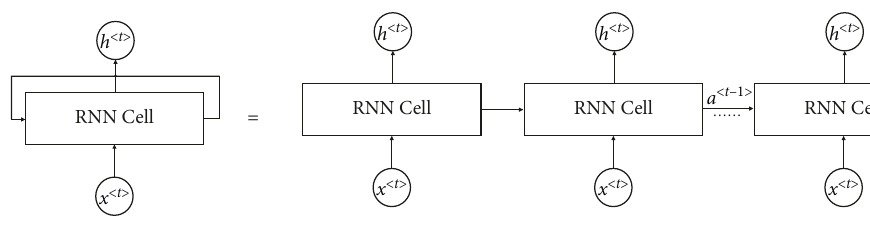
Figure 1: Structure of RNN.